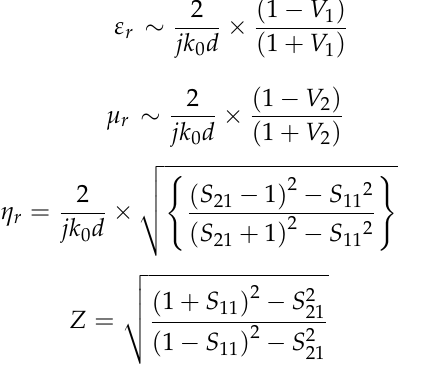
Figure 2. Simulation geometry of the proposed unit cell. Table 1. The design specification of modified Coptic cross shape-based metamaterial.